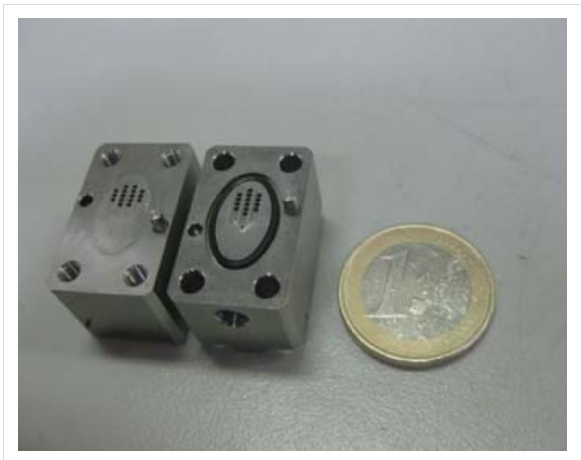
Figure 1: Hastelloy-made micromixer (MiChS β -150H).